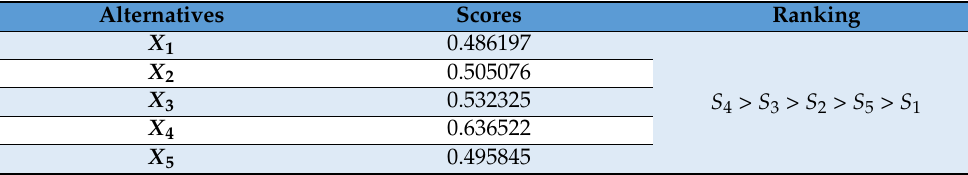
Table 13. The score values of the aggregated information.